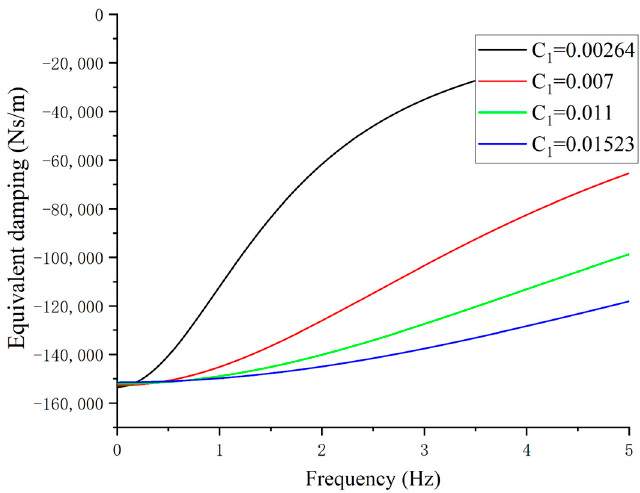
Figure 4. The equivalent damping of VEI–VD.